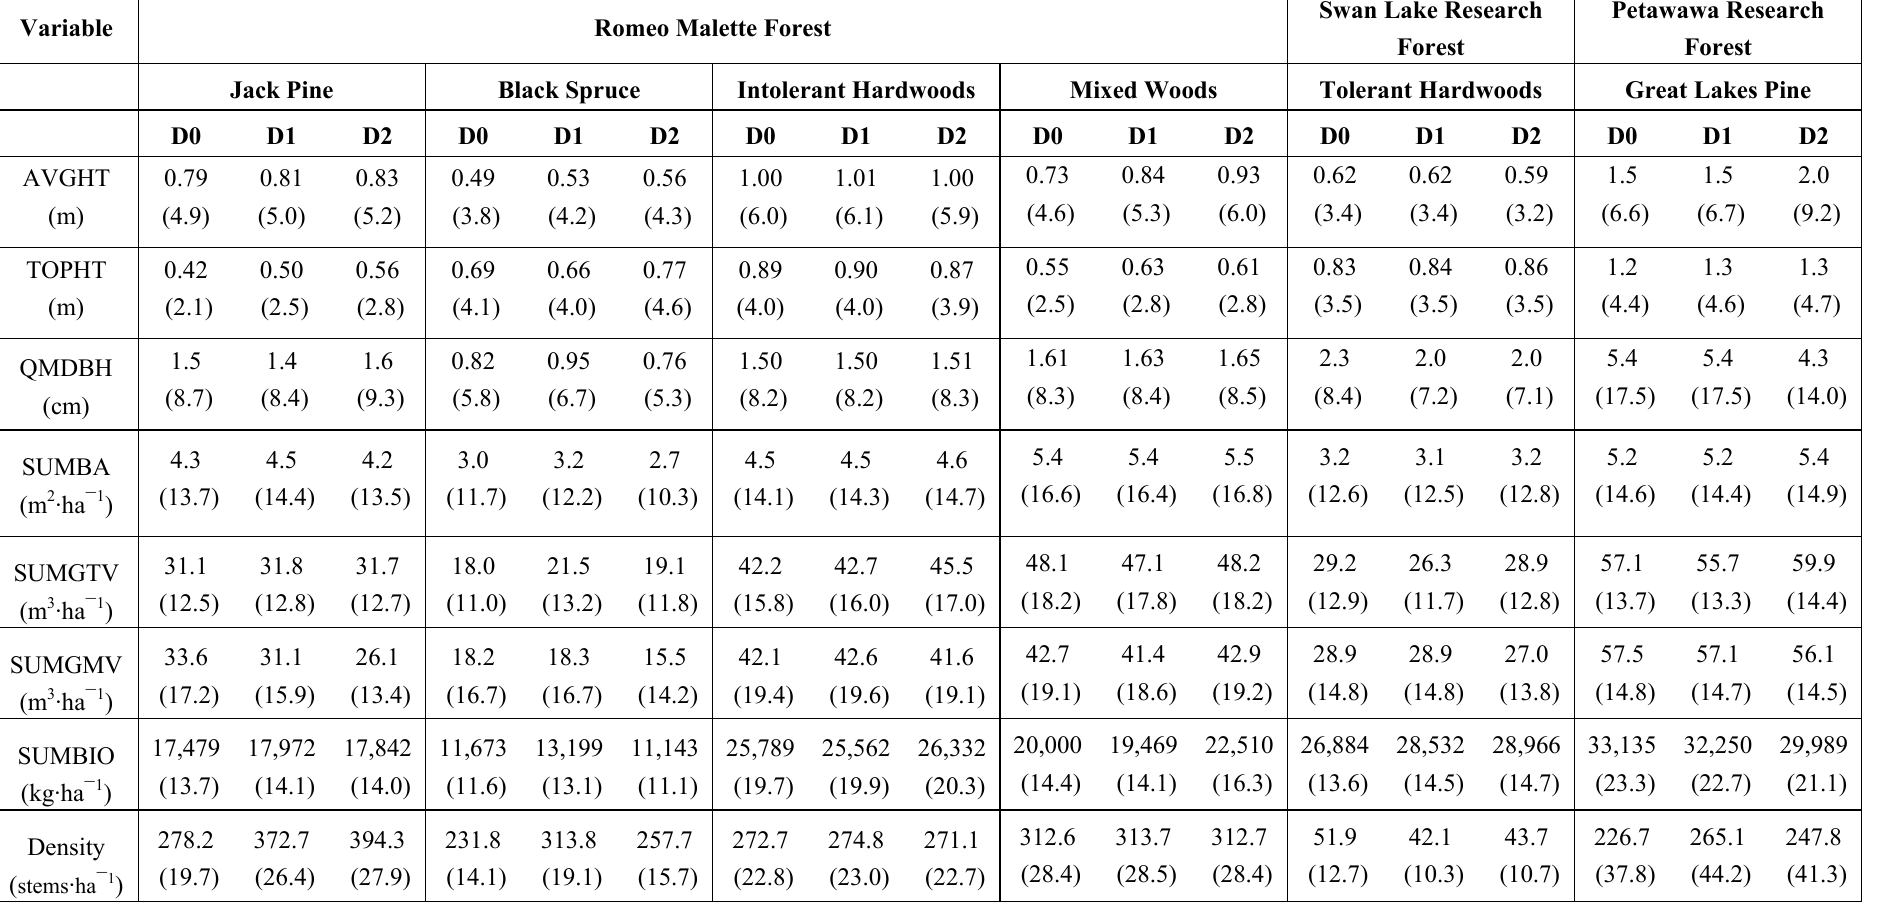
Table 5. Root Mean Square Errors (RMSEs) for model developed for variables, based on forest inventory plots in the Romeo Malette Forest, Swan Lake Research Forest and Petawawa Research Forest. RMSEs are presented for each of the decimation levels ( i.e. , D0 ~ 3.2 pulses m − 2